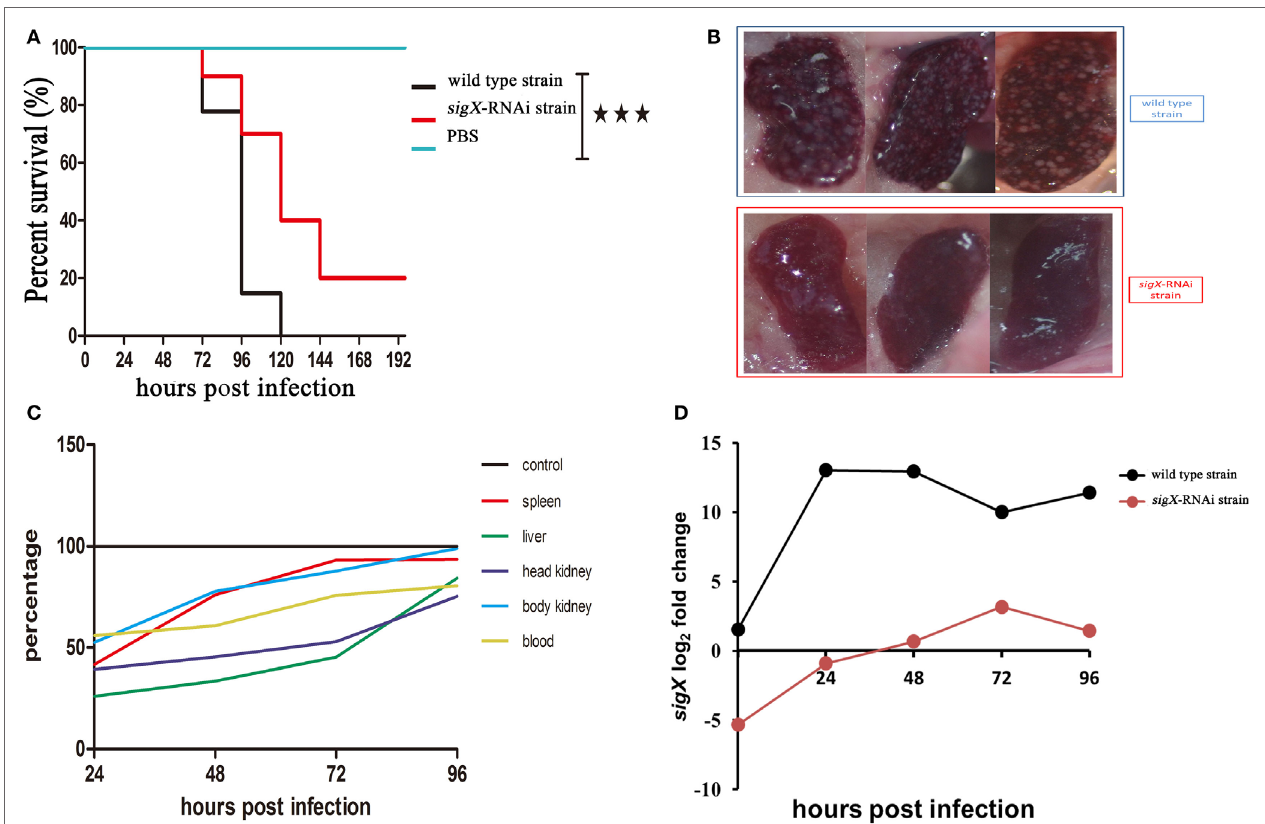
FigUre 2 | The virulence of wild-type strain and sigX -RNAi strain of Pseudomonas plecoglossicida . (a) Survival rate of Epinephelus coioides infected by P. plecoglossicida . (B) Symptoms of spleen of E. coioides infected by P. plecoglossicida . (c) Spatial and temporal distribution of sigX -RNAi strain P. plecoglossicida compared to wild-type strain. (D) Expression level of sigX gene of P. plecoglossicida in the spleen of E.